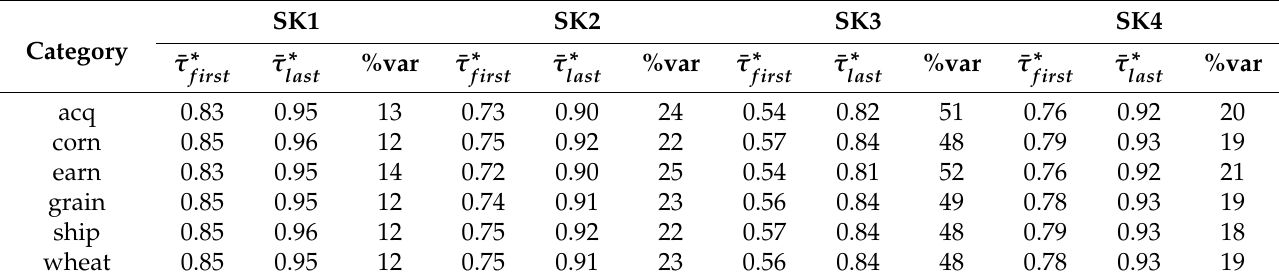
Table A4. Average of the computed collective concordance indices per category ( m = 6).